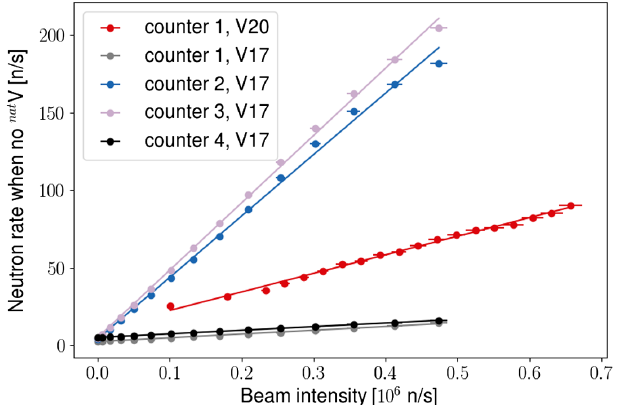
14. The x-axis shows the absolute beam intensity flowing through the setup when no vanadium was present. The y axis shows the values recorded by the 3 He proportional counters. The rate is linear and depends on the distance r of the 3 He proportional counter from the center of the